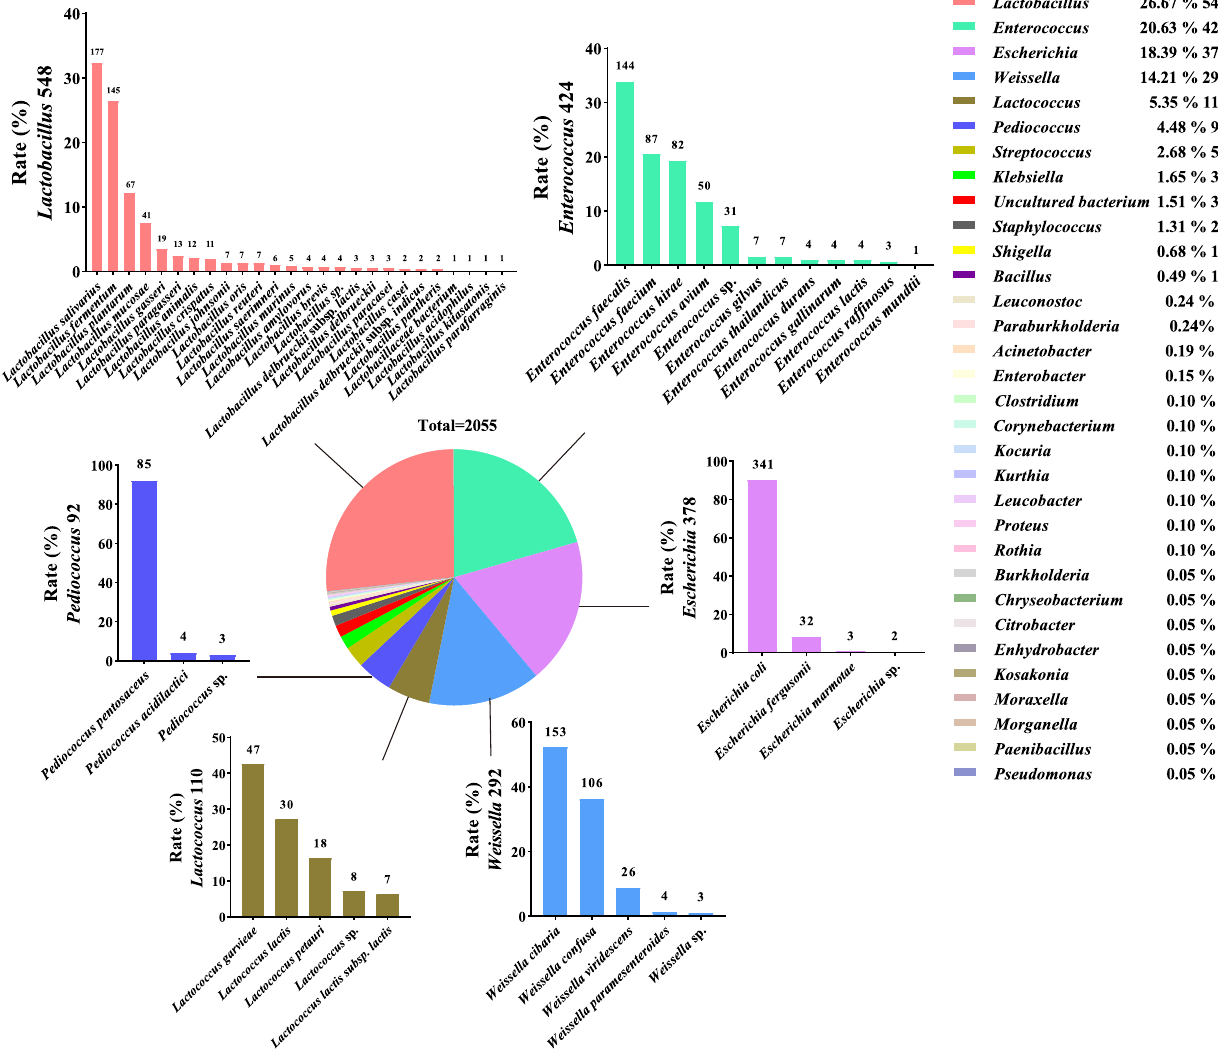
Fig. 5 Targeted separation of age-related gut microbiota. The pie chart illustrating the proportion of all strains isolated from the fecal sample at the genus level, and a total of 2,055 strains were isolated. The bar graph showing the detailed composition of the top 6 genera isolated from the fecal sample, including Lactobacillus, Enterococcus, Escherichia, Weissella, Lactococcus, Pediococcus